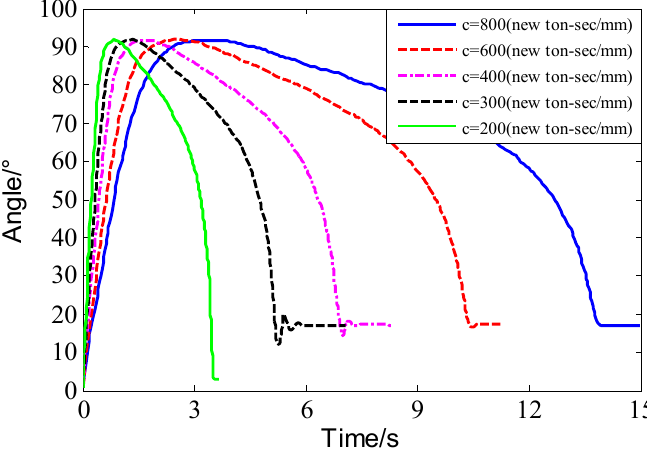
Figure 6. Angle change of forward door under different damping coefficients.